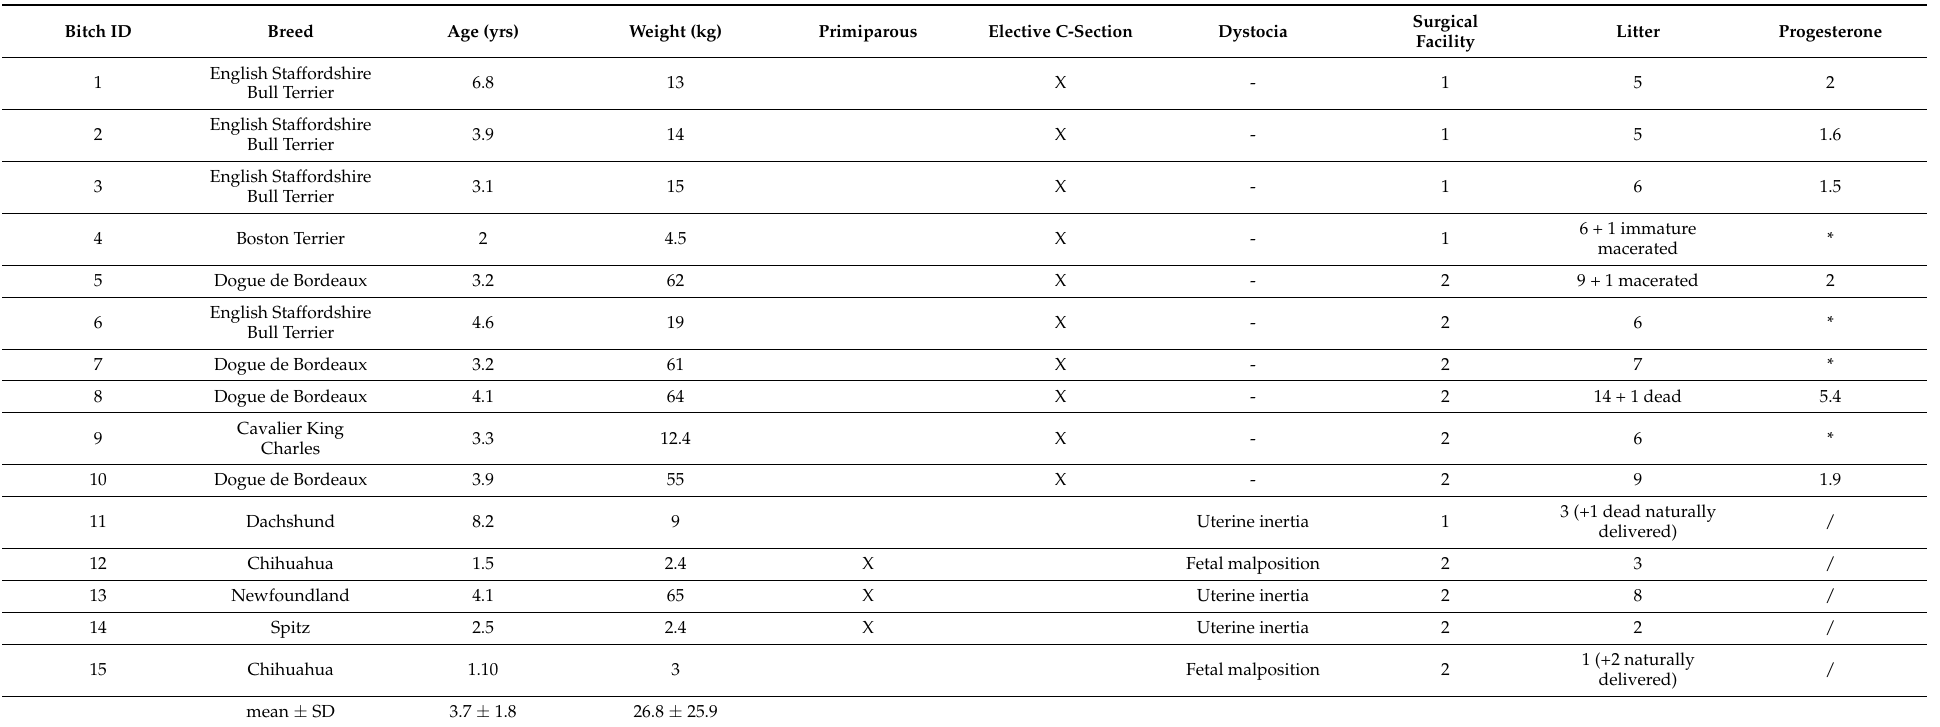
Table 1. Breed, age, weight and parity of the bitches included in the